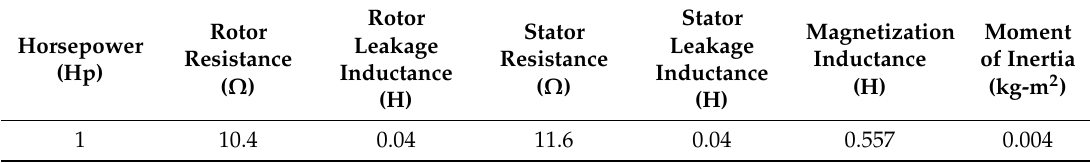
Table 6. Parameter of the three-phase inductor motor.